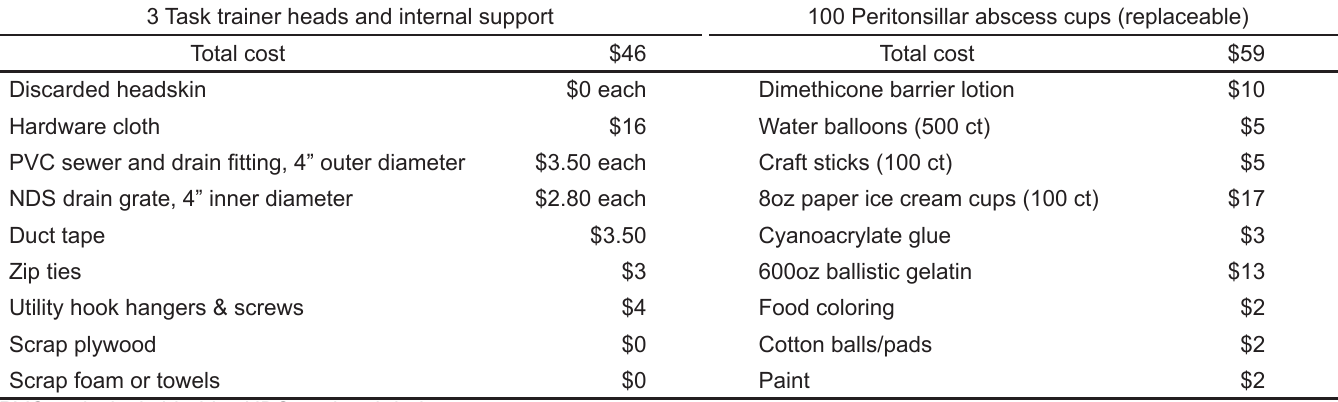
Table. Materials for peritonsillar abscess